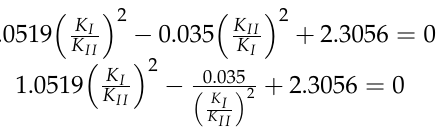
Discarding the complex region (square root of a negative number), Figure 3 shows K eq / K I as a function of K I / K II and of K II / K I . Clearly, Equation (19) does not apply to all domains of K I and K II ; it presents zeroes for K I / K II = 0.178 and K II / K I = 8.144. Nevertheless, it follows the expected trend of the solution for K I / K II > ~0.4 and for K II / K I < ~4, as shown in Figure 3, where for comparison it is plotted together with Tanaka’s